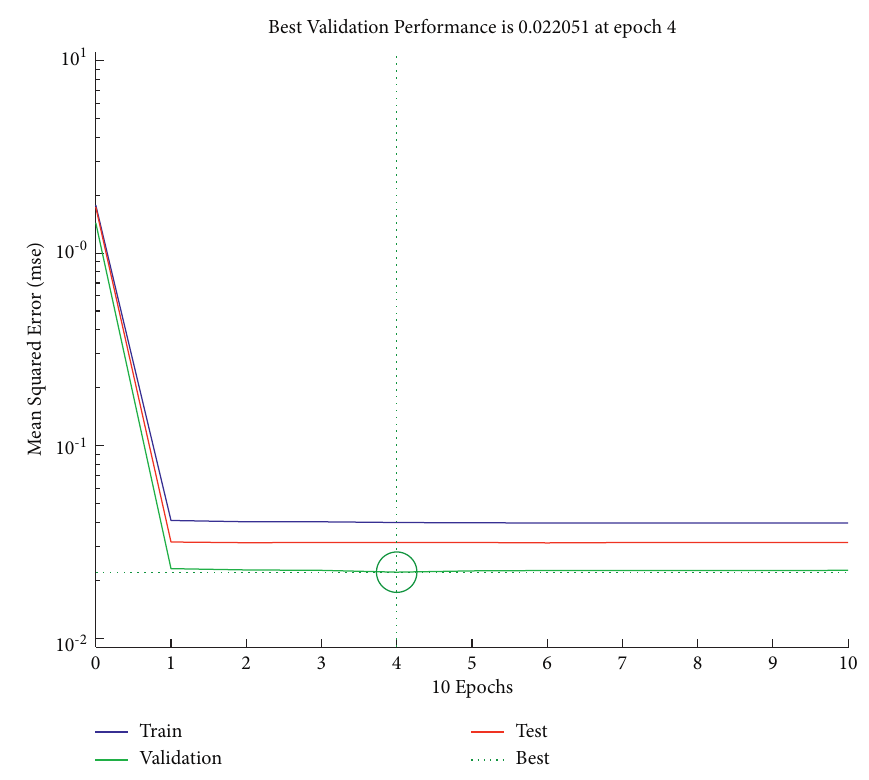
Figure 16: Best validation performance is 0.022051 at epoch